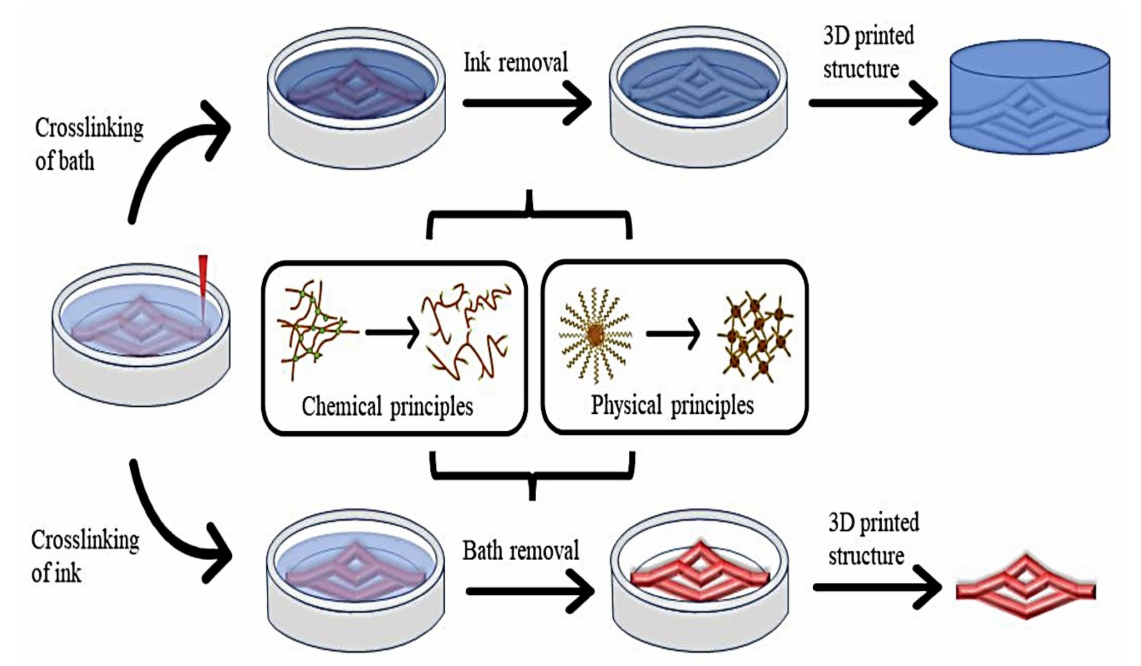
Figure 4. Diagrammatic representation of applications of biomaterials centered on physio-chemical cross-linking principles. Reprinted with permission from [137]. Copyright 2022 MDPI.